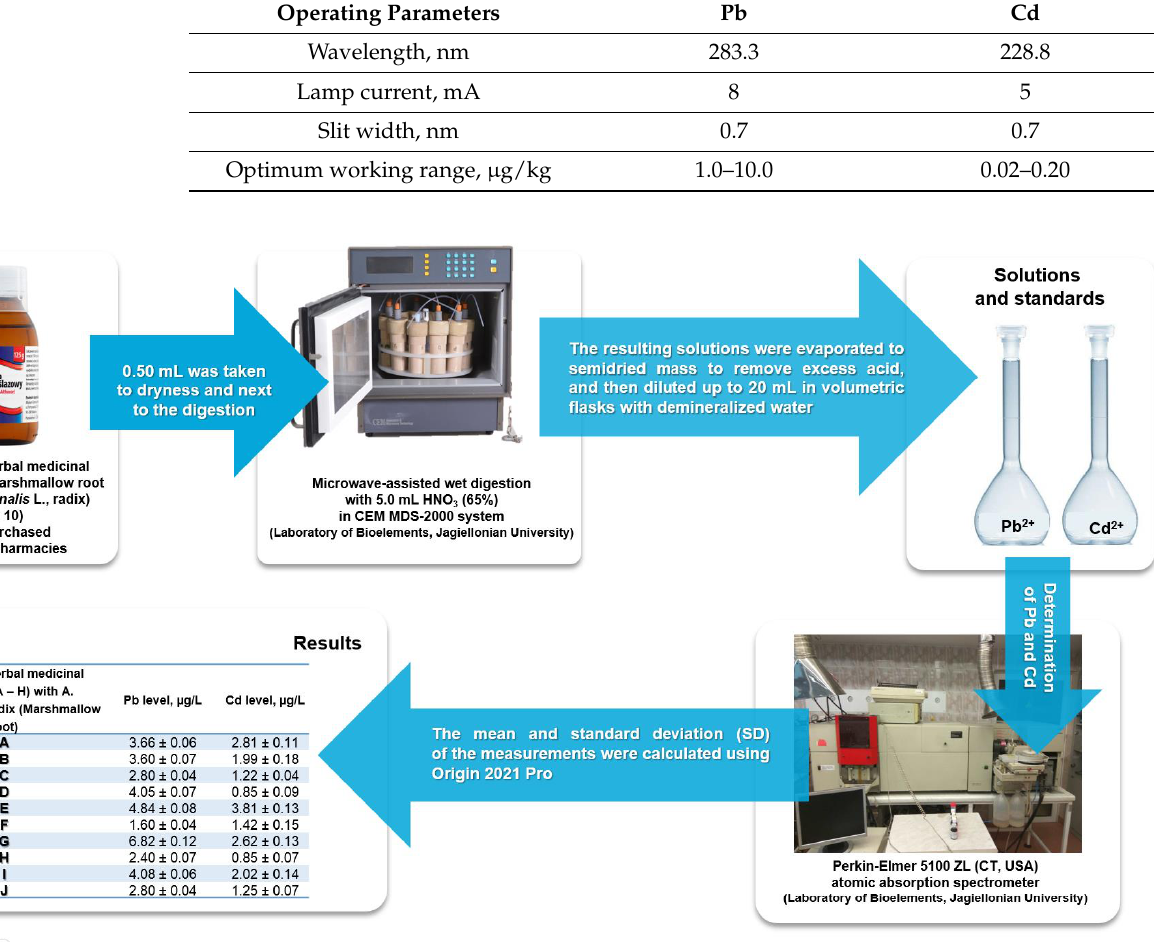
Figure 1. The workflow of the applied toxicological assessment of lead and cadmium in investigated traditional herbal medicinal products with Althaea officinalis L., radix (marshmallow root) collected from pharmacies in Poland. Table 2. Time – temperature program in the graphite furnace atomic absorption spectrometer for Pb and Cd determination.